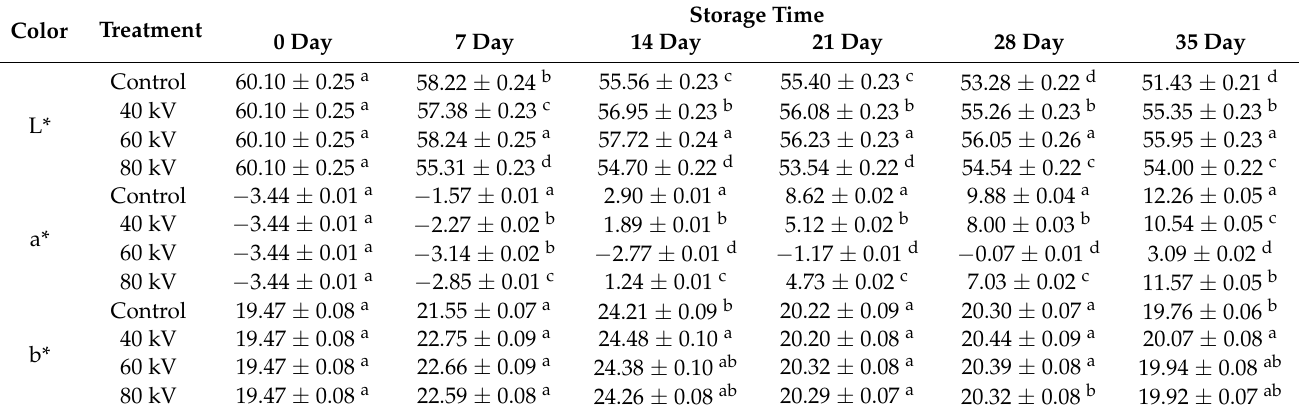
Table 2. Effects of different intensities of ACP treatment on the color of